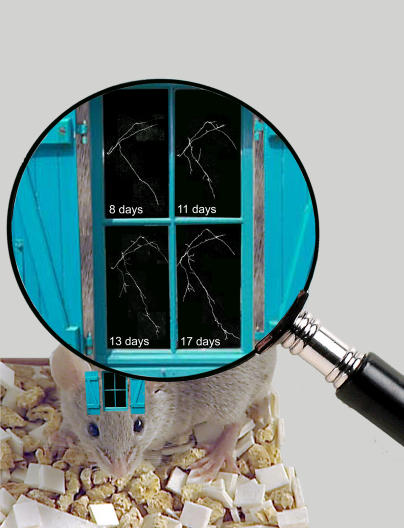
Implanting “windows” into the skulls of newborn mice allowed researchers to observe axon development